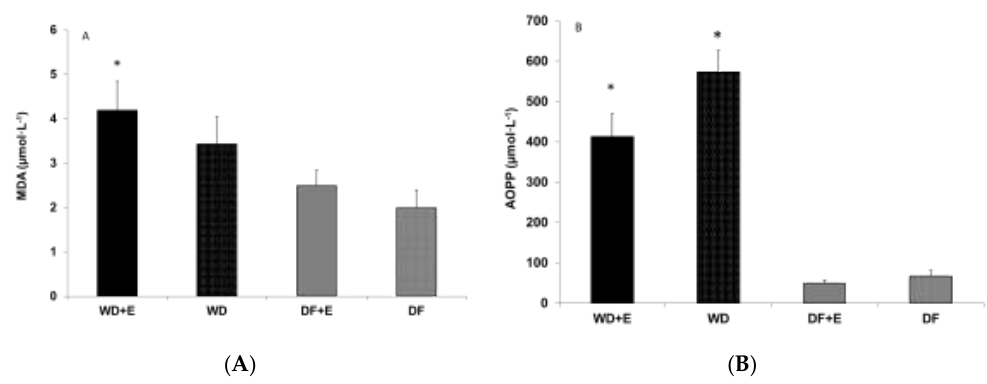
Figure 2. ( A ) Blood malondialdehyde (MDA) and ( B ) advanced oxidation protein products (AOPP) of male rats assigned to two different diets with and without exercise. Values are mean ± SEM. * A group effect was noted for MDA ( p = 0.03) and AOPP ( p < 0.0001). For AOPP, the Western Diet (WD) group resulted different from all the other groups; also the Western Diet + Exercise (WD + E) group resulted different than all the other groups ( p < 0.05). For MDA, the Western Diet + Exercise (WD + E) group resulted different from the DF group ( p < 0.05). Table 4. Cytokine concentrations in male rats assigned to two different diets with and without exercise.